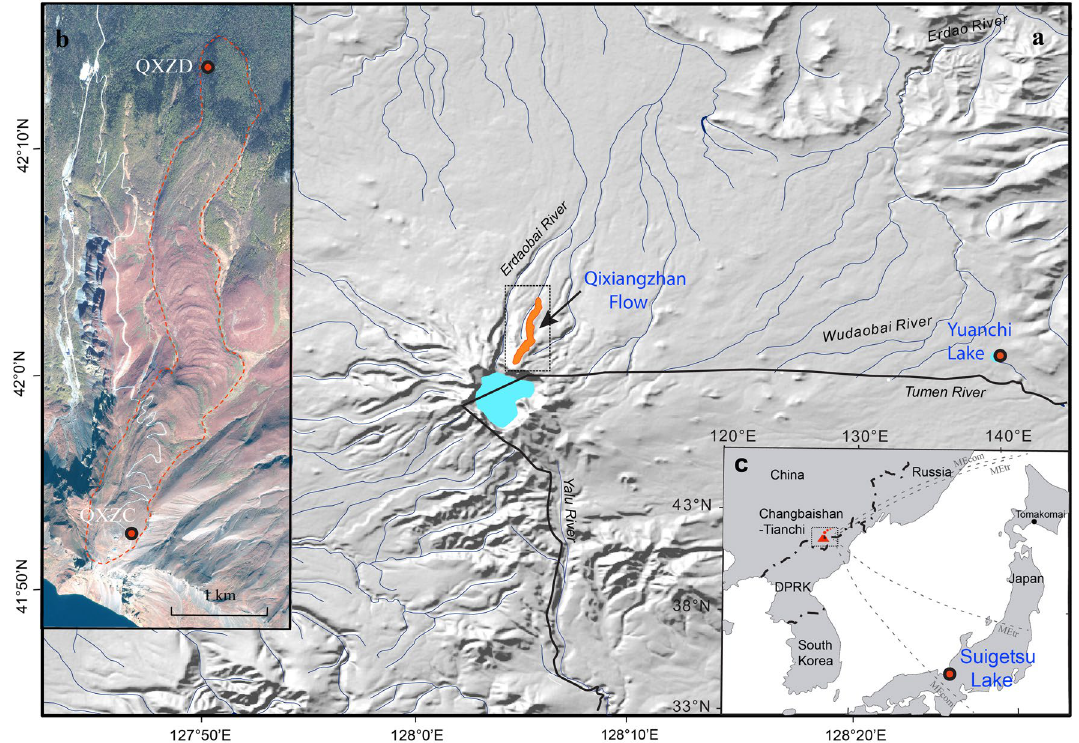
Figure 1. Geographic context and details of the Qixiangzhan (QXZ) eruption from Changbaishan-Tianchi volcano. ( a ) Shaded relief of the Changbaishan-Tianchi volcano and local environs showing the location and distribution of the Qixiangzhan lava flow on the north slope of Changbaishan-Tianchi caldera. Solid black line is the international border between China and the DPRK. ( b ) Satellite image of the Qixiangzhan lava flow and showing our sample locations. ( c ) Broader regional context of Changbaishan-Tianchi volcano showing locations where correlatives of the tephra/ash of the Qixiangzhan eruption have been